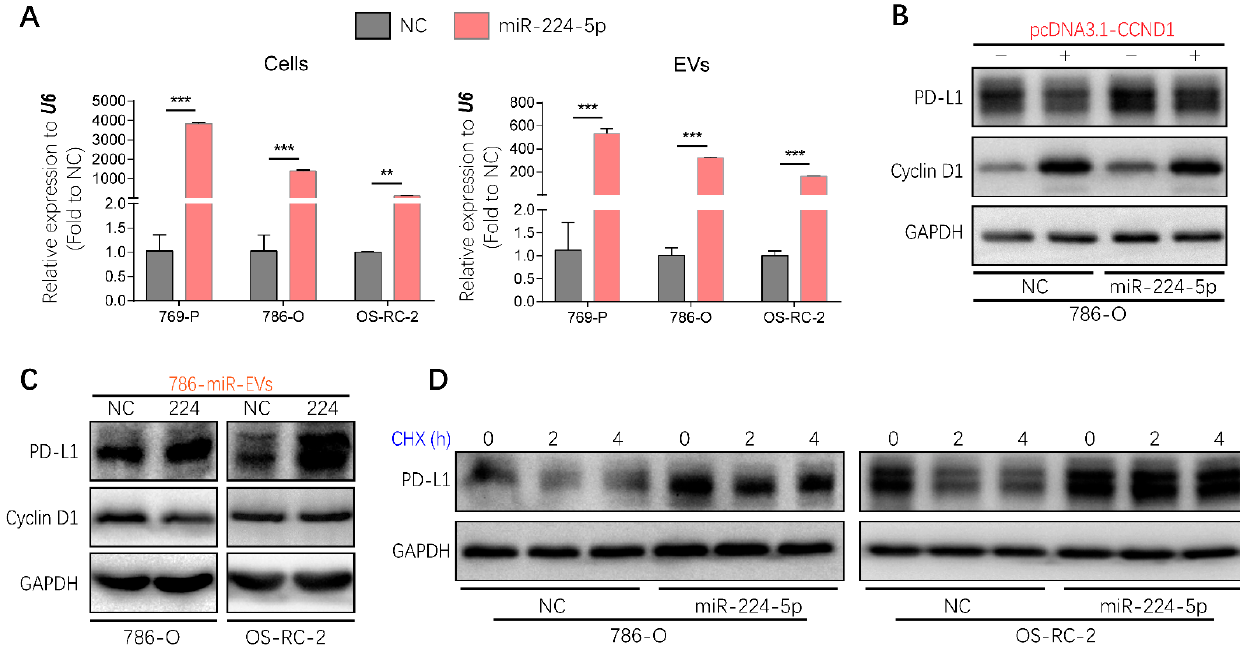
Figure 7. Regulation of PD-L1 protein expression by miR-224-5p inhibiting cyclin D1 expression could be transmitted between RCC cells by EVs. ( A ) miR-224-5p levels in RCC-NC/miR-224-5p cells and EVs were determined by RT-qPCR (** p < 0.01; *** p < 0.001). ( B ) Protein levels of cyclin D1 and PD-L1 in CCND1 transiently expressed 786-O-NC/miR-224-5p cells were detected by Western blot. ( C ) Protein levels of PD-L1 and cyclin D1 in RCC cells co-culturing with EVs derived from 786-O-NC/miR-224-5p cells for 24 h were detected by Western blot. ( D ) PD-L1 protein stability in RCC-NC/miR-224- 5p cells was detected after CHX (25 mg/mL) treatment for indicated time (h) as shown in the figure. (Original Western blots see Figure S7).